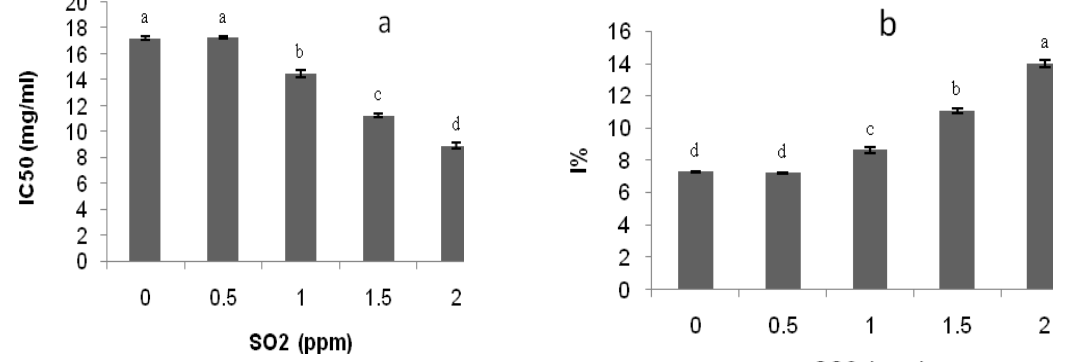
Fig. 1. (a) Antioxidant capacities (IC 50 ) and (b) antioxidant activities (I %) in the leaves of alfalfa under SO 2 pollution in 45 days plants. Data are mean ± SE. Different letters indicate that the mean value is significantly different (p<